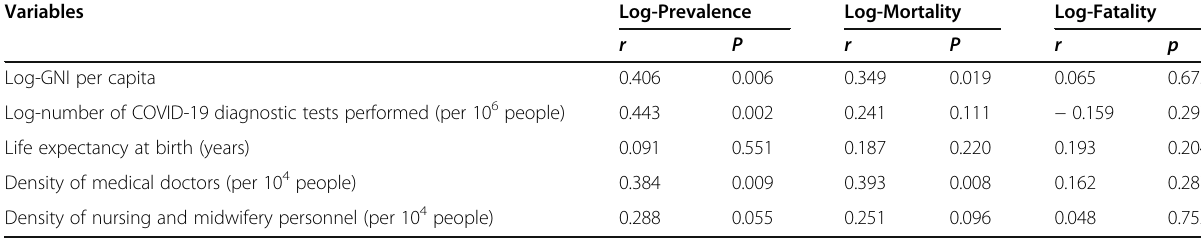
Table 1 Correlation between log-transformed of epidemiologic parameters and selected risk factors